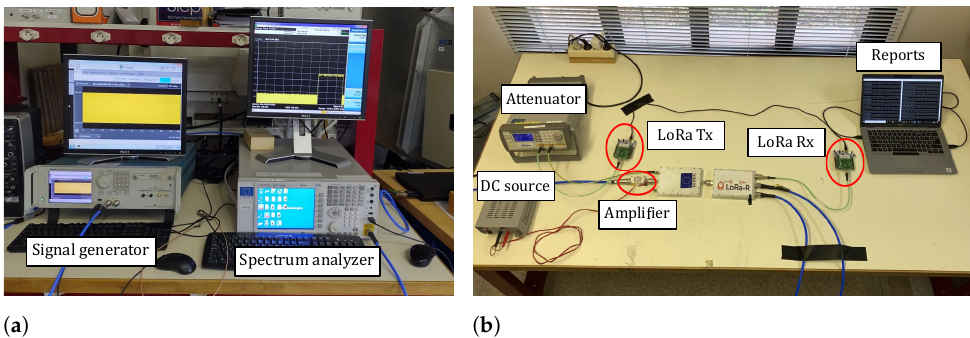
Figure 6. Pictures of the test setup. The main equipment are ( a ) a signal generator and a signal analyzer and ( b ) LoRa transceivers, splitters, an amplifier fed by a direct current source, a variable attenuator and a laptop to monitor the